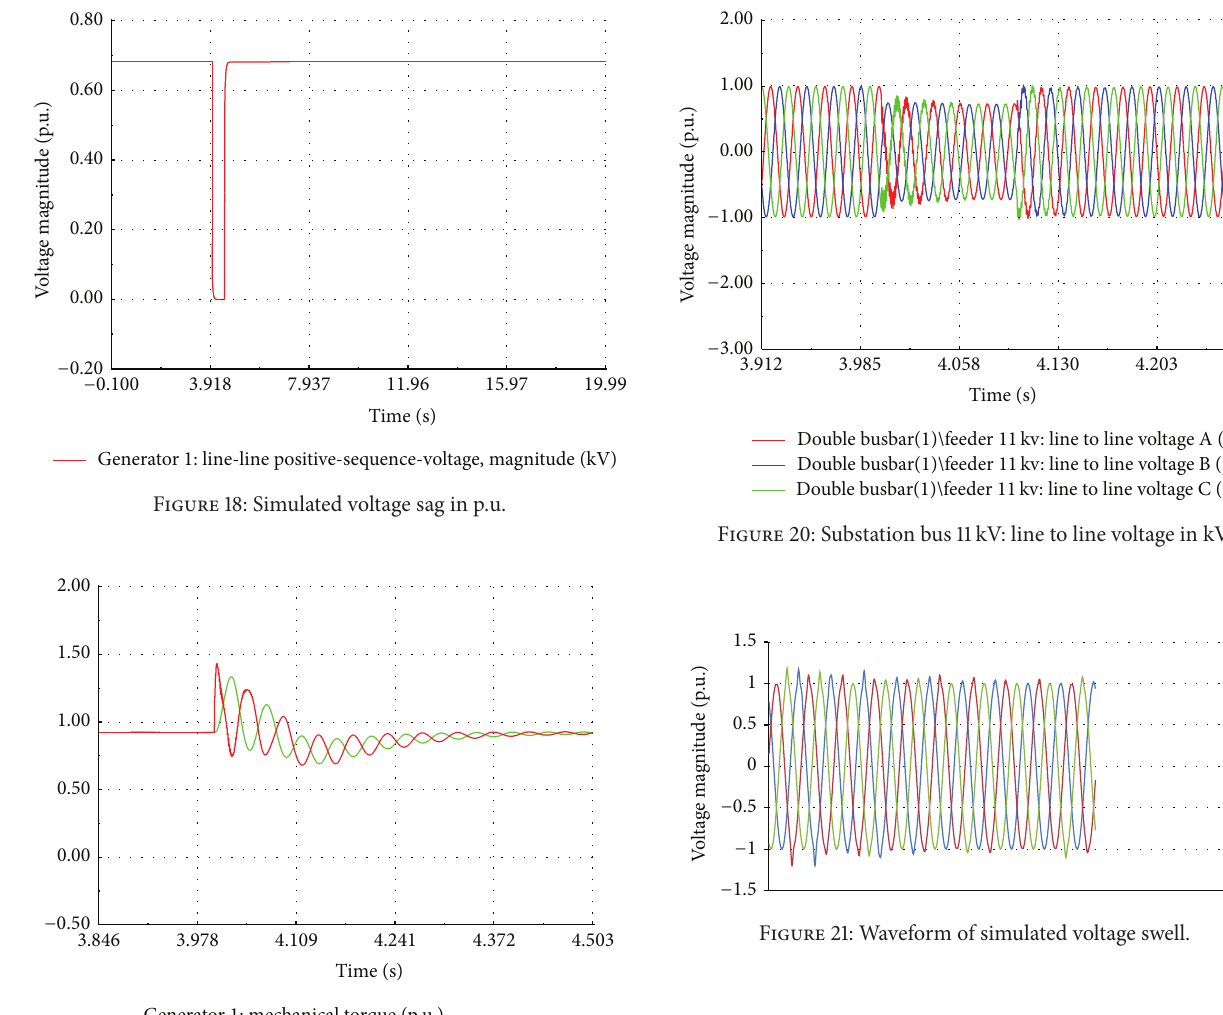
Table 2: Voltage profile. Voltage in